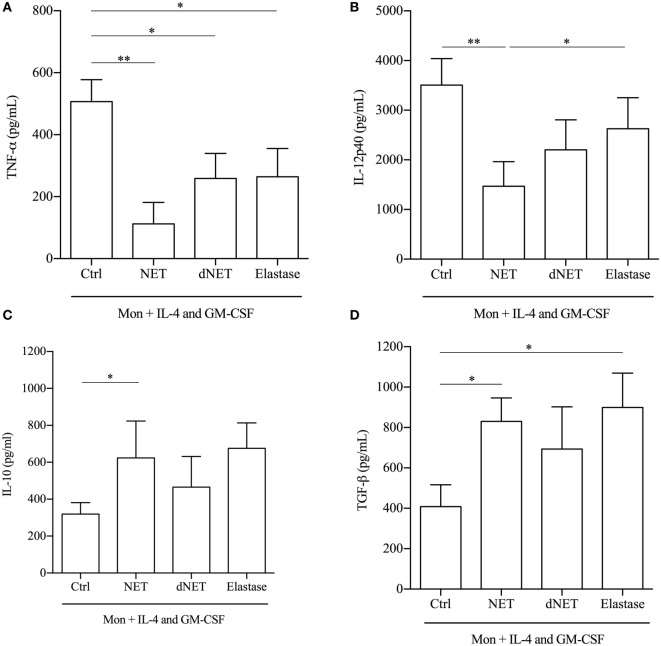
Cytokines produced by neutrophil extracellular traps (NETs)-treated monocytes. Monocytes were treated or not with NETs, digested NETs (dNETs), or recombinant elastase. After 18 h at 37°C/5%CO2, IL-4 and GM-CSF were added and cells were maintained at 37°C/5%CO2. At day 5, lipopolysaccharide (100 ng/mL) was added to the culture. After 72 h of activation, cytokine production was evaluated by ELISA. Results of at least eight experiments are shown as mean ± SEM. (A) **P < 0.01; *P < 0.05. (B) **P < 0.01; *P < 0.05. (C) Paired t-test analysis was performed and *P < 0.05. (D) *P < 0.05.